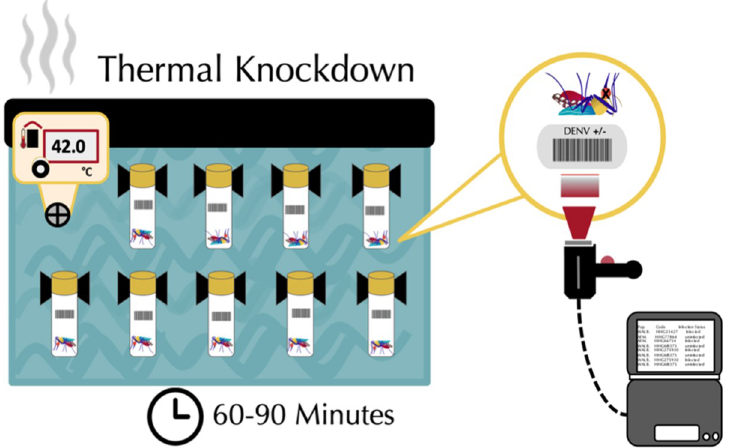
Fig 1. Experimental setup to measure thermal sensitivity of DENV- and Wolbachia- infected mosquitoes.